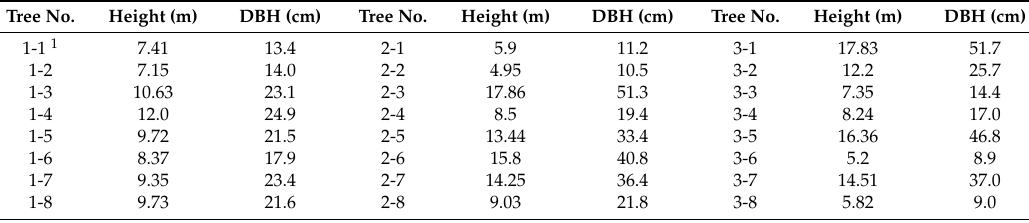
Table A1. The measured heights and DBHs of the sample trees in five plots of the test site. Tree